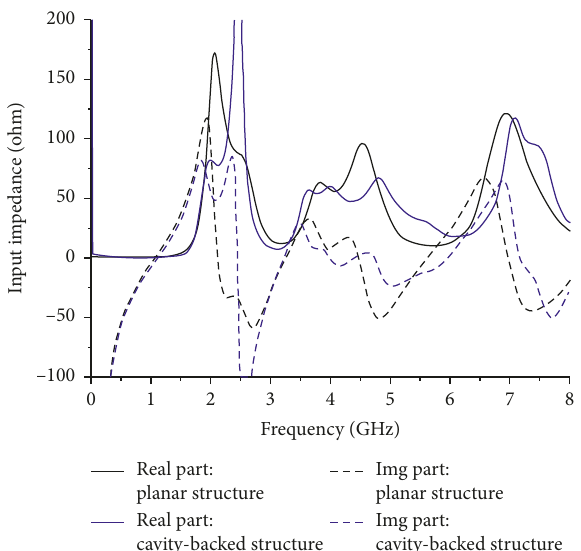
Figure 3: Simulated input impedance in free-space of the planar and cavity-backed